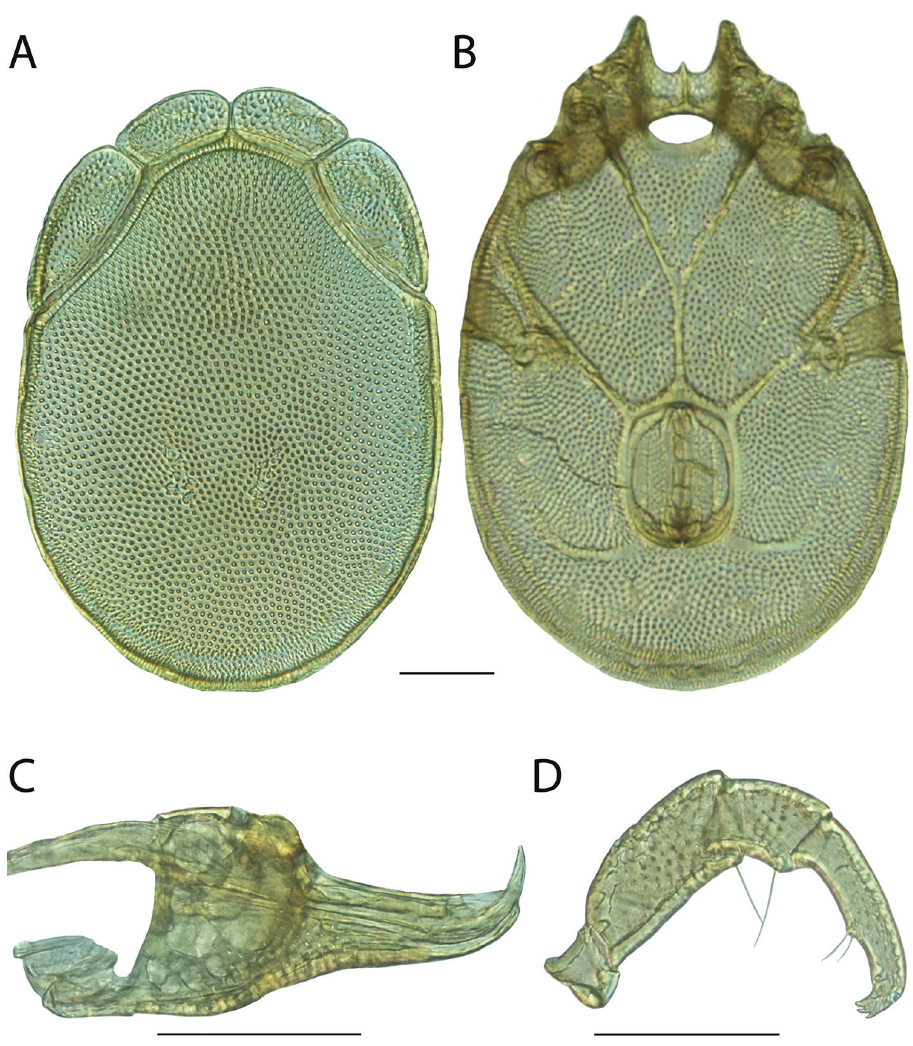
Figure 95. Torrenticola hoosieri sp. n. male: A dorsal plates B venter (legs removed) C subcapitulum D pedipalp (setae not accurately depicted). Scale = 100